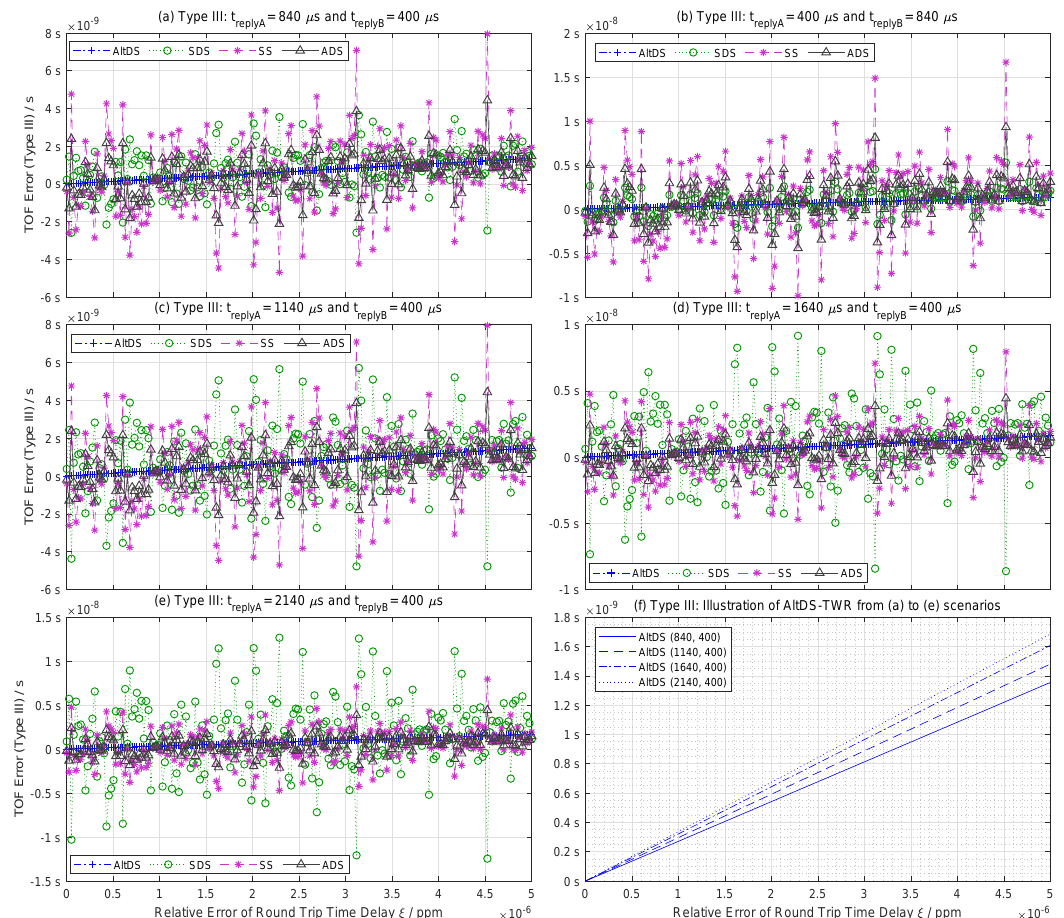
Figure 5. TOF error comparison between TWR methods using Type III assumption (typical case) as in Equations (28)–(31). ( a ) TOF error when t replyA > t replyB , ( b ) TOF error when t replyA < t replyB , ( c ) TOF error when t replyA = 1140µs and t replyB = 400µs, ( d ) TOF error when t replyA = 1640µs and t replyB = 400µs, ( e ) TOF error when t replyA = 2140µs and t replyB = 400µs, and ( f ) TOF error specifically for AltDS-TWR method at different reply